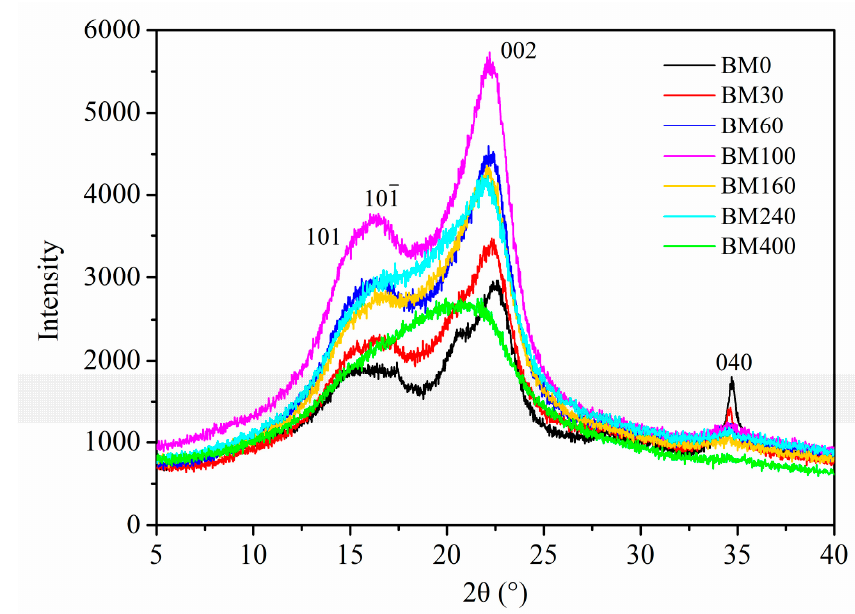
Figure 5. XRD patterns of PIDF samples at different scales.